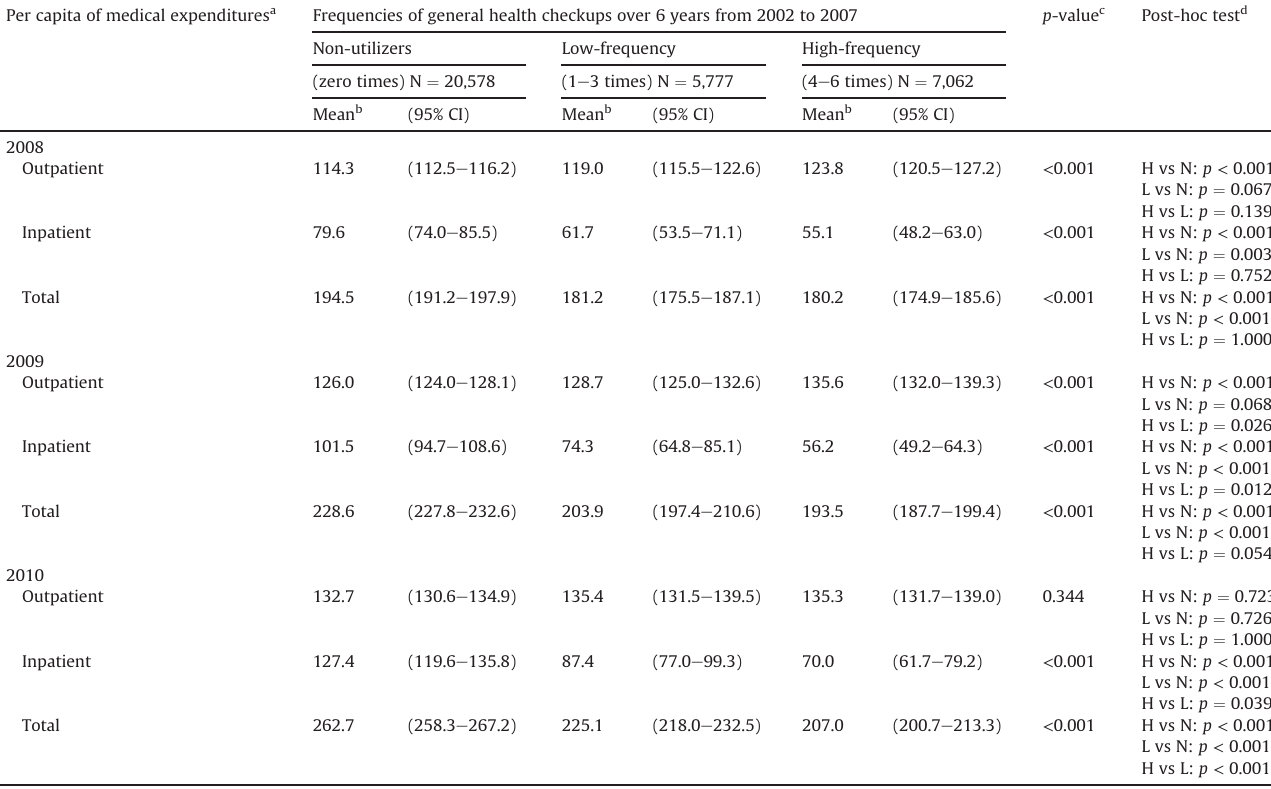
Table 3 Comparison of medical expenditures according to subgroups of general health checkup utilization. Per capita of medical expenditures a Frequencies of general health checkups over 6 years from 2002 to